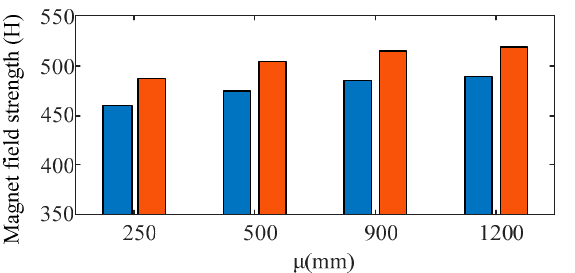
Figure 18. Magnetic field strength curves of shields of NiZn with different depths and different relative permeabilities.